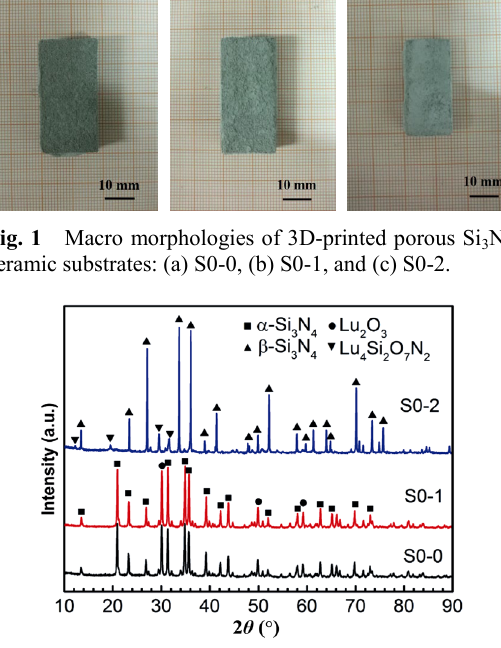
Fig. 2 XRD patterns of porous Si 3 N 4 ceramic